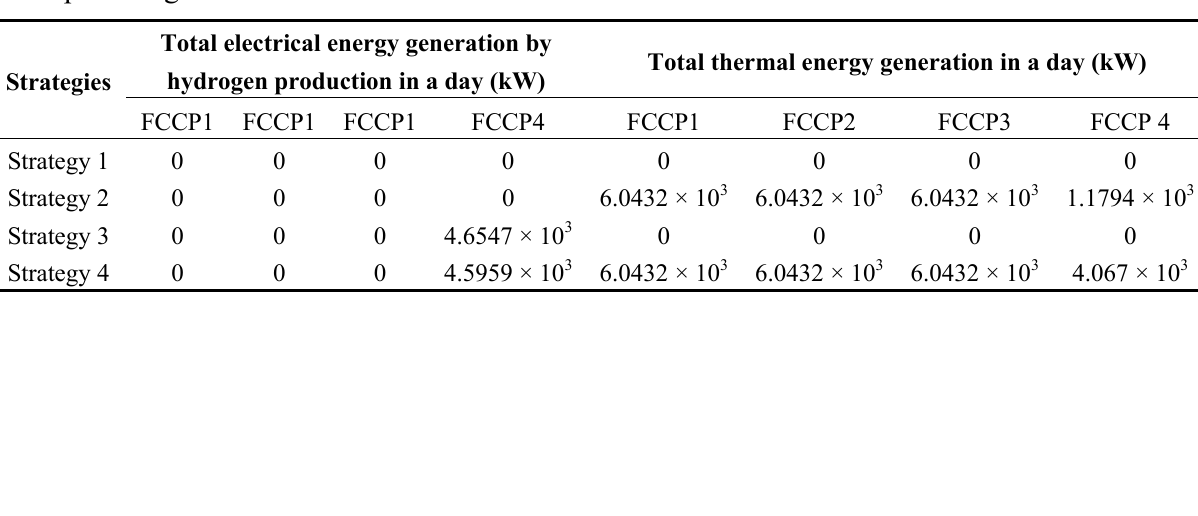
Table 5. Results obtained for thermal energy & hydrogen production for FCPPs by optimizing the